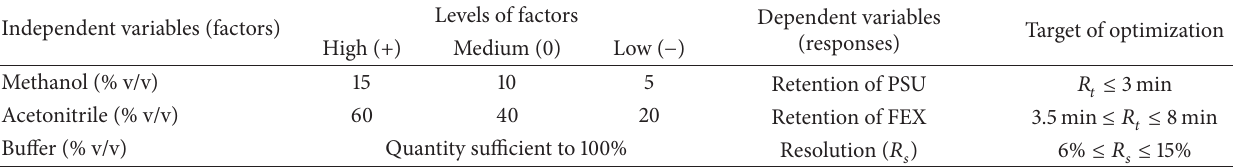
Table 2: Independent variables (factor) and responses investigated in CCD